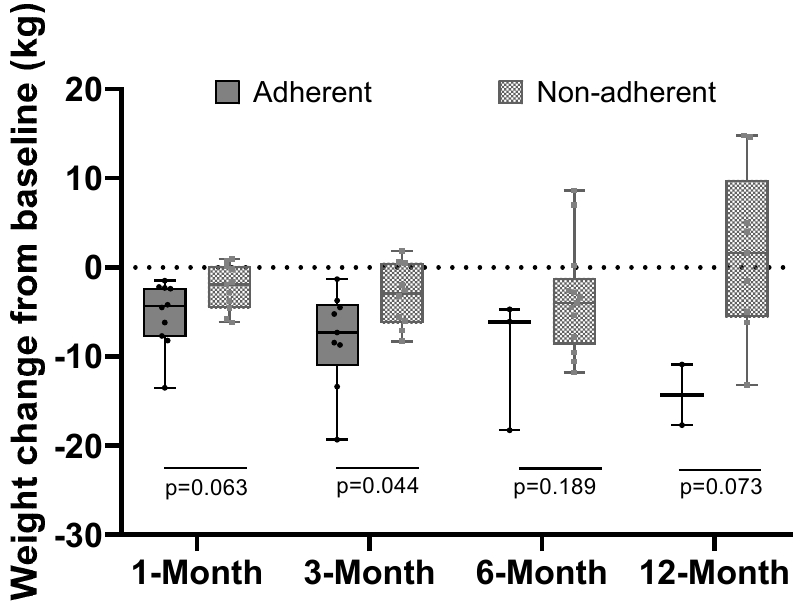
Figure 3. Weight change by adherence to rPSMF.